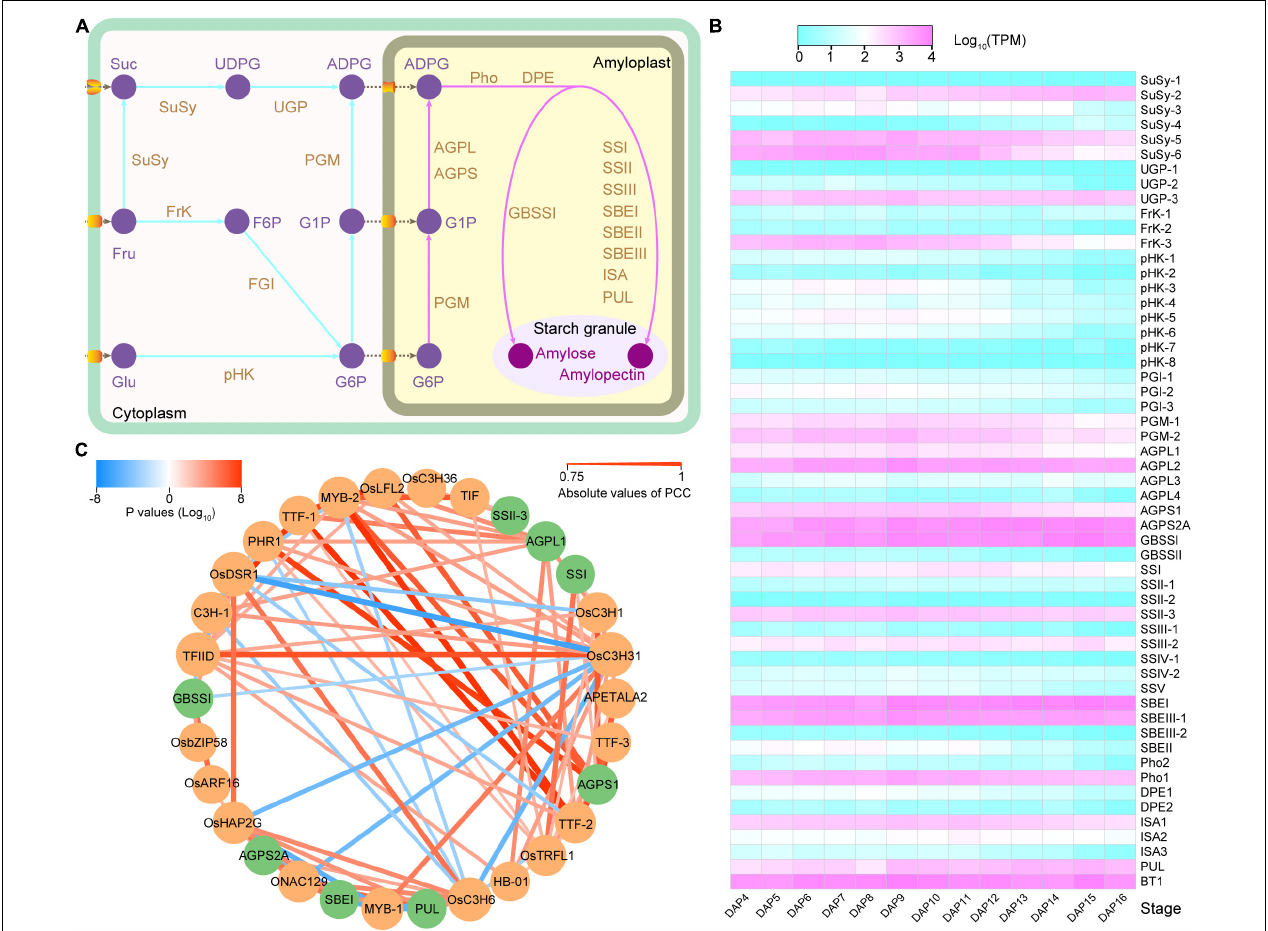
FIGURE 5 | Gene expression and regulation network of starch synthesis-related gene. (A) Starch synthesis pathway in rice endosperm. (B) Starch synthesis-related gene expression profile. (C) Co-expression network of 8 starch synthesis-related genes (SSRGs) and 22 transcription factors (TFs). The green and orange colors represent SSRGs and TFs, respectively. The line color indicates the P -value, and the red and blue shades represent the positive regulation and negative regulation, respectively. The width of the line represents the correlation; the wider the line, the higher is the